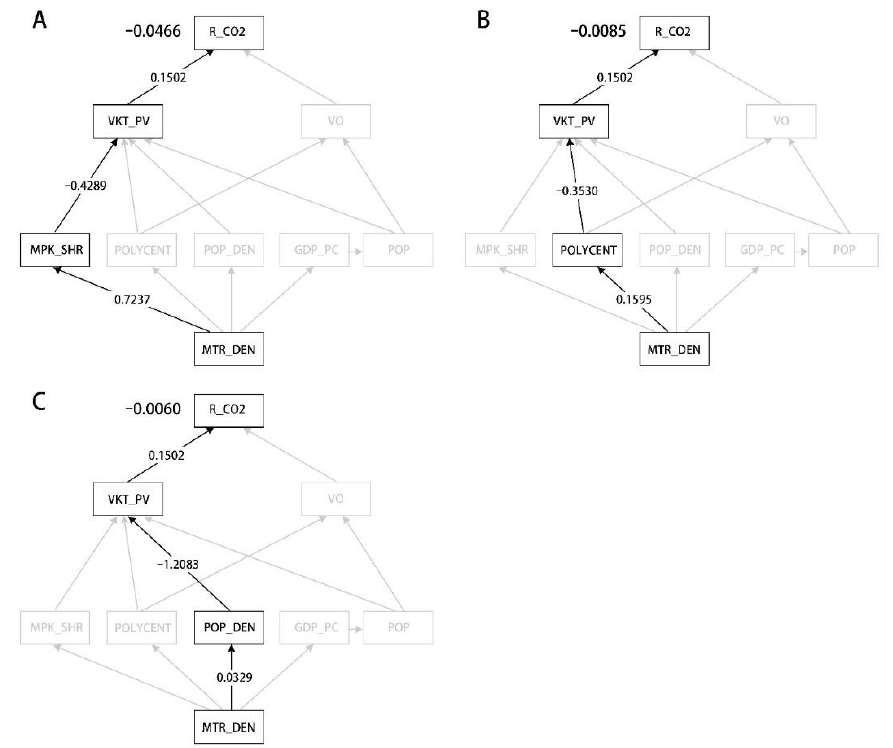
Figure 4. Negative Effects of Metro Density on Traffic-related Carbon Emissions: Mediators of ( A ) MPK_SHR; ( B ) POP_DEN; ( C ) POLYCENT. Source: Created by the authors from Table 4.